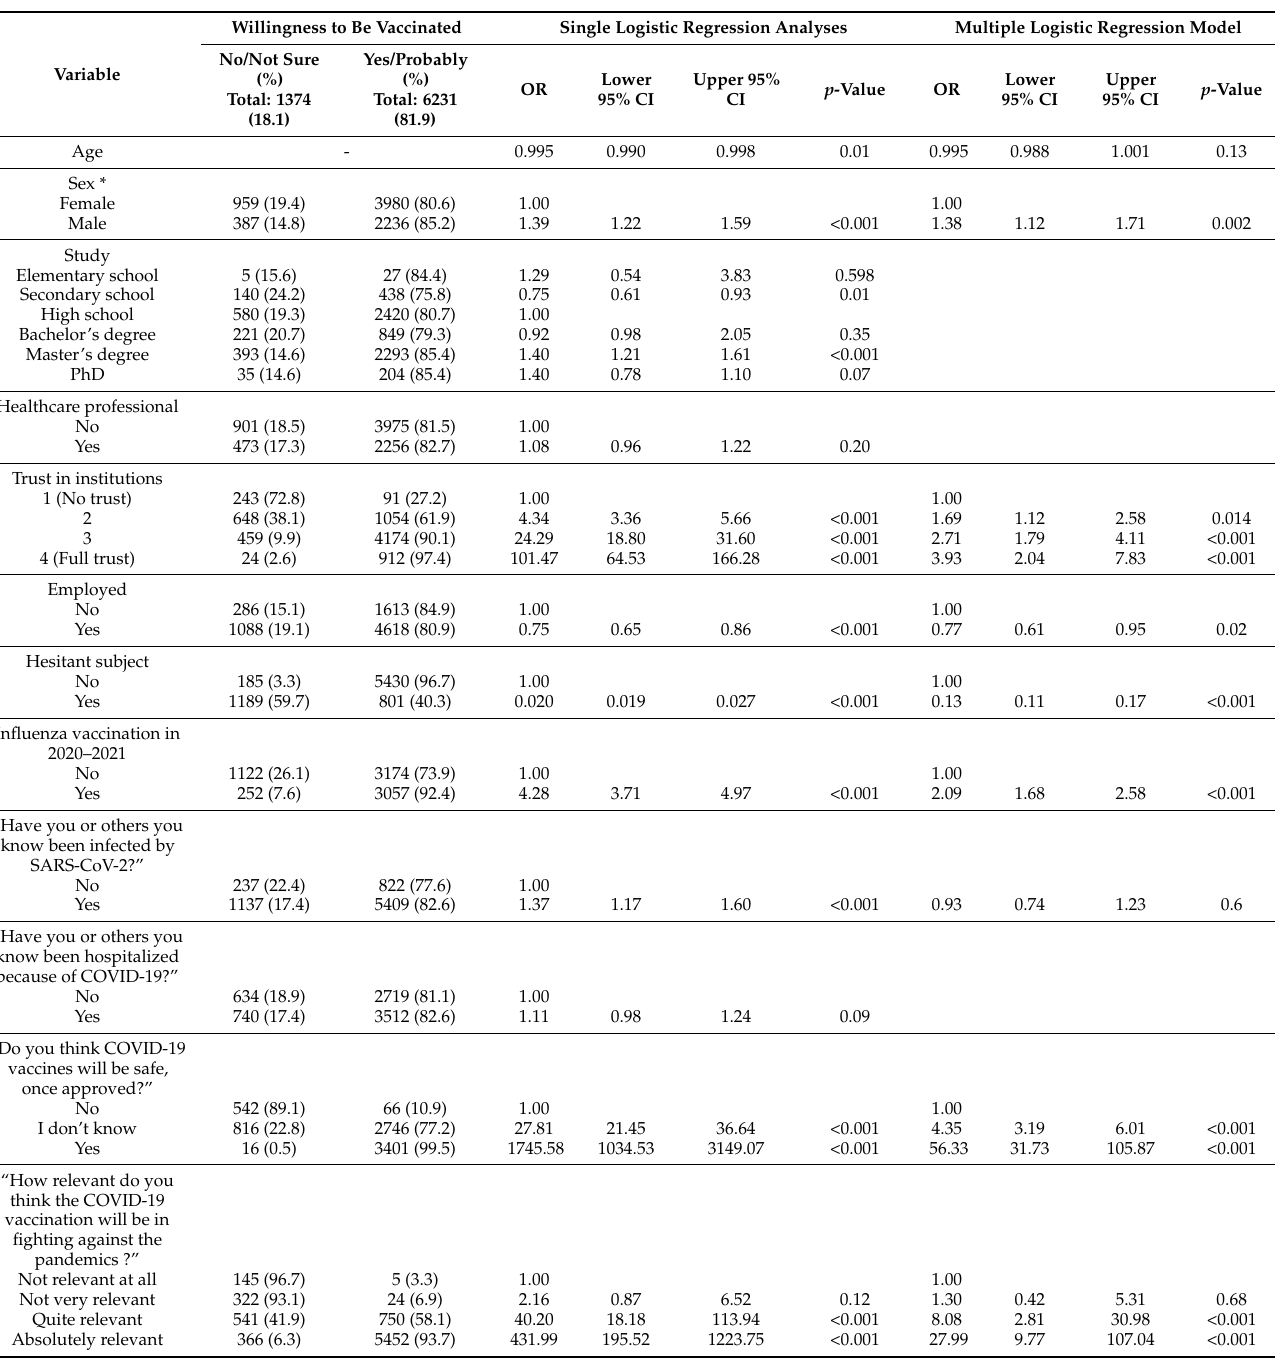
Table 3. Variables associated with the willingness to be vaccinated against COVID-19. From the left: the first column shows the variables included in the analyses. The second column shows the “willingness to be vaccinated” among the categories reported in each item. The third and the fourth columns show the results of the single logistic regression analyses and the results of the multiple logistic regression